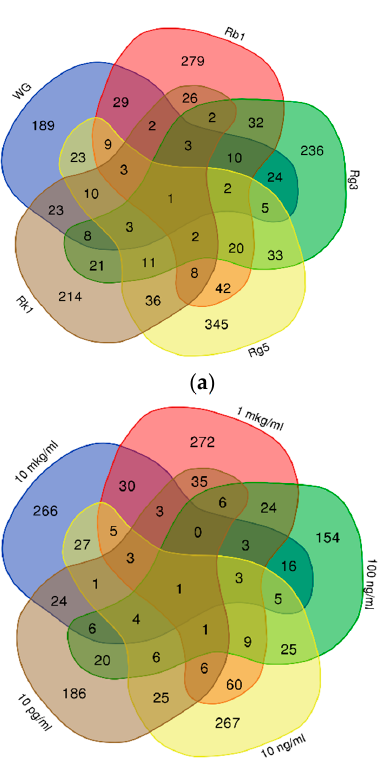
Table 1. The number of genes deregulated (>20 fold compared to controls) by ginsenosides Rb1, Rg3, Rg5 and Rk1, WG